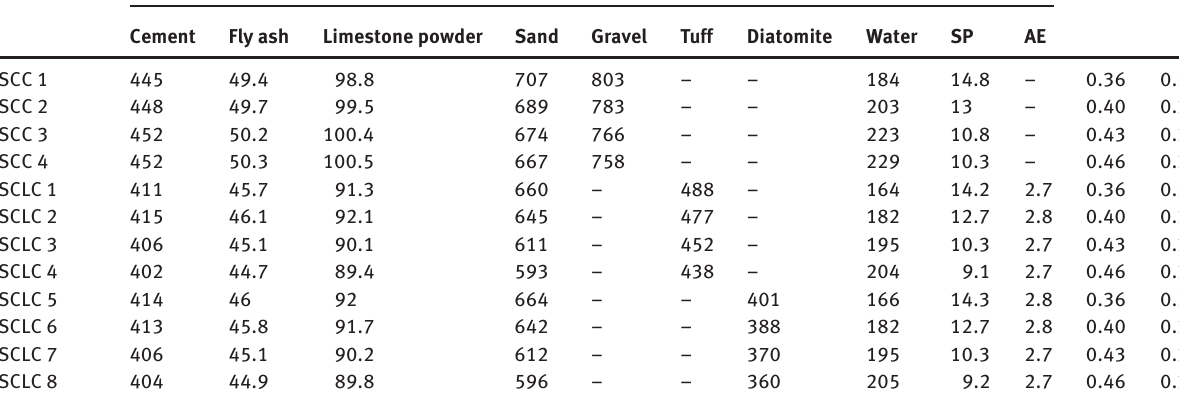
Table 3 Actual constituent of concretes per cubic meter. 1 Cement + fly ash.